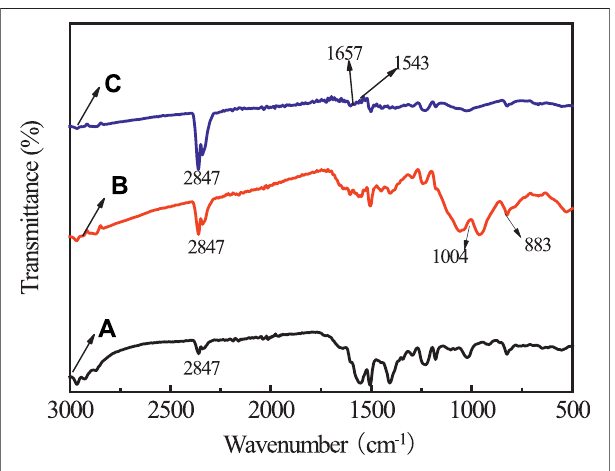
FIGURE 2 | The XRD spectra for rusty carbon steel (A) , 5 wt% PA solutiondropped on rustycarbon steel (B) ,and PA/G coating coated on rusty carbon steel (C)